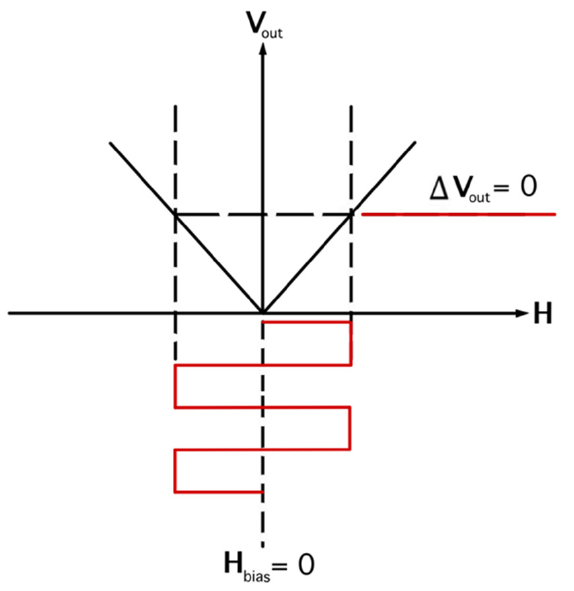
Figure 3. The voltage output as a function of applied magnetic field when H bias = 0.